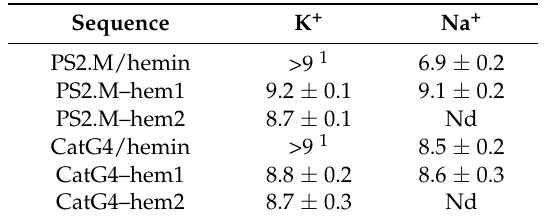
Figure 2. Dependences of the ratio of absorbances at 360 nm and 404 nm (A 360 /A 404 ) for hemin-containing systems against the pH, allowing the determination of acid dissociation constant (pKa) values. Conditions: 1 µ M DNA, 1 µ M hemin (if present), and 100 mM KCl or NaCl. Experiments were performed in triplicate. Table 3. Values of the acid dissociation constant (pKa) for the studied systems determined in the presence of potassium or sodium cations. The pKa values were averaged across three